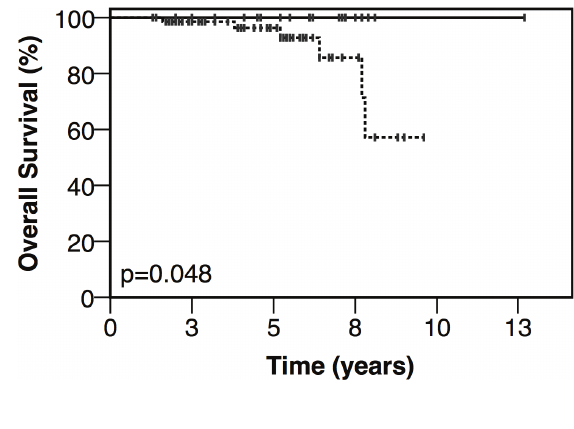
Figure 3 - Kaplan-Meier estimates of OS in intermediate- risk prostate cancer patients treated with EBRT and a palladium-103 (…) or an iodine-125 (__) LDR brachytherapy